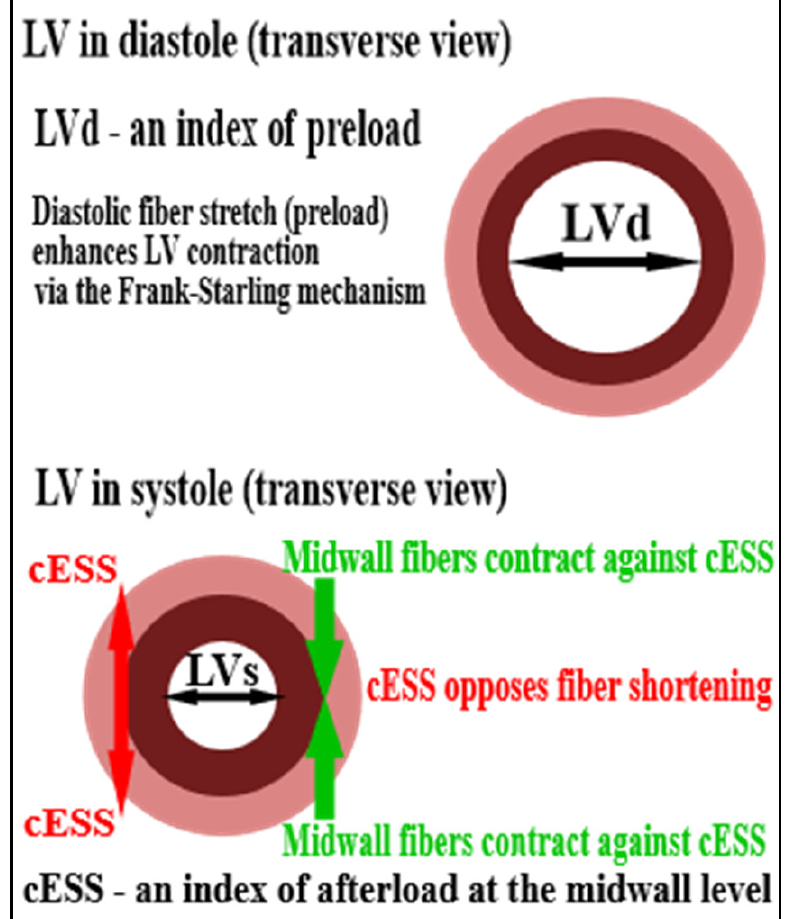
Figure 3. An indirect insight into load-independent intrinsic LV systolic function (i.e., contractility) by means of the analysis of relations between LV systolic performance (mwFS, LV midwall fractional shortening) and surrogate indices of LV afterload (cESS, circumferential end-systolic LV midwall stress) and preload (LVd, end-diastolic LV internal